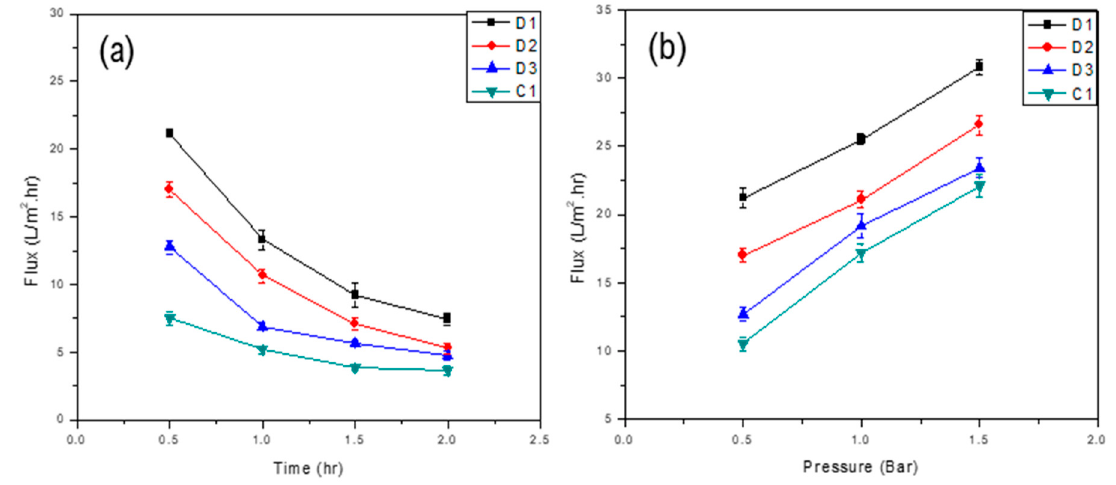
Figure 6. Flux of D ‐ type membranes as a function of ( a ) time and ( b ) transmembrane pressure. Figure 6. Flux of D-type membranes as a function of ( a ) time and ( b ) transmembrane